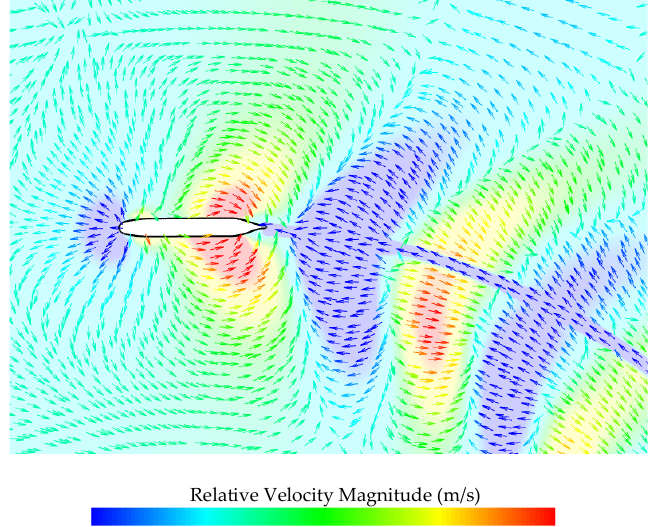
Figure 11. Velocity vector field on the plane of z = 0.